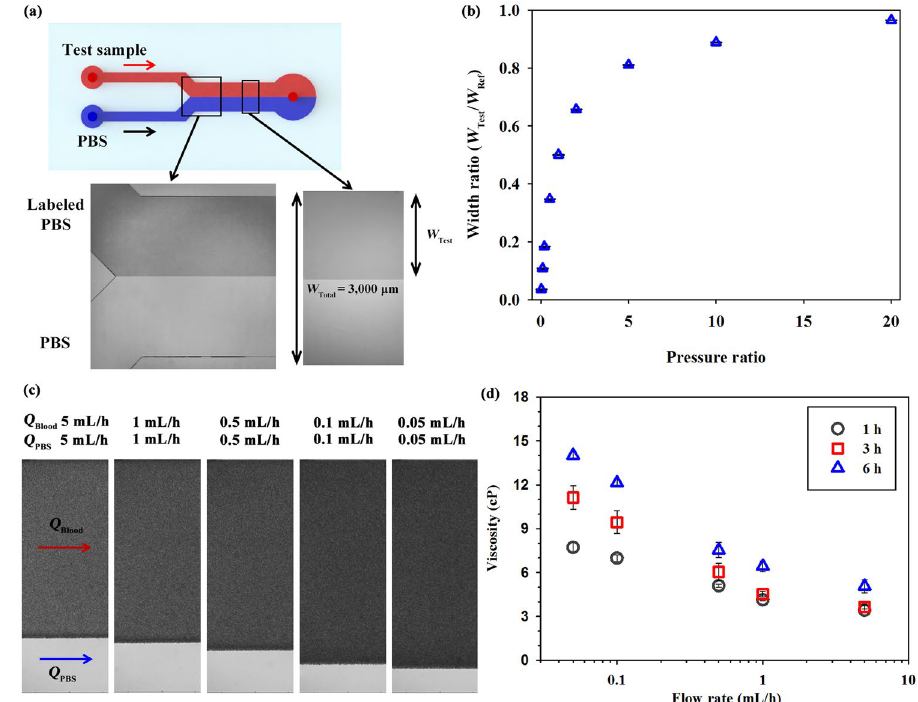
Figure 2. Measurement of variation in viscosity based on interfacial width between the test sample and PBS solution. ( a ) Schematic of the Y-shaped microfluidic device. An interfacial line is formed between the test sample and PBS solution by separately delivering the two fluids to each inlet of the microfluidic device. Optical images of the labeled PBS and PBS flows in the confluence region and interesting region. The channel downstream has a width ( W Total ) of 3000 μ m and a height ( H ) of 50 μ m. The width of the test fluid ( W Test ) is measured with image processing techniques. ( b ) Variation of the width ratio ( W Test /W Total ) according to pressure ratio between the labeled PBS and PBS solutions. After obtaining a fitting curve of the width ratio based on the regression analysis for the labeled PBS and PBS solutions, the pressure ratio between the two fluids is estimated from the width ratio curve. ( c ) Magnified images representing variations in the interfacial width of the blood samples ( W Test ) and PBS solution according to flow rate ( Q Blood and Q PBS = 0.05 − 5 mL/h). ( d ) Variations in blood viscosity according to flow rate and lapsed time after LPS